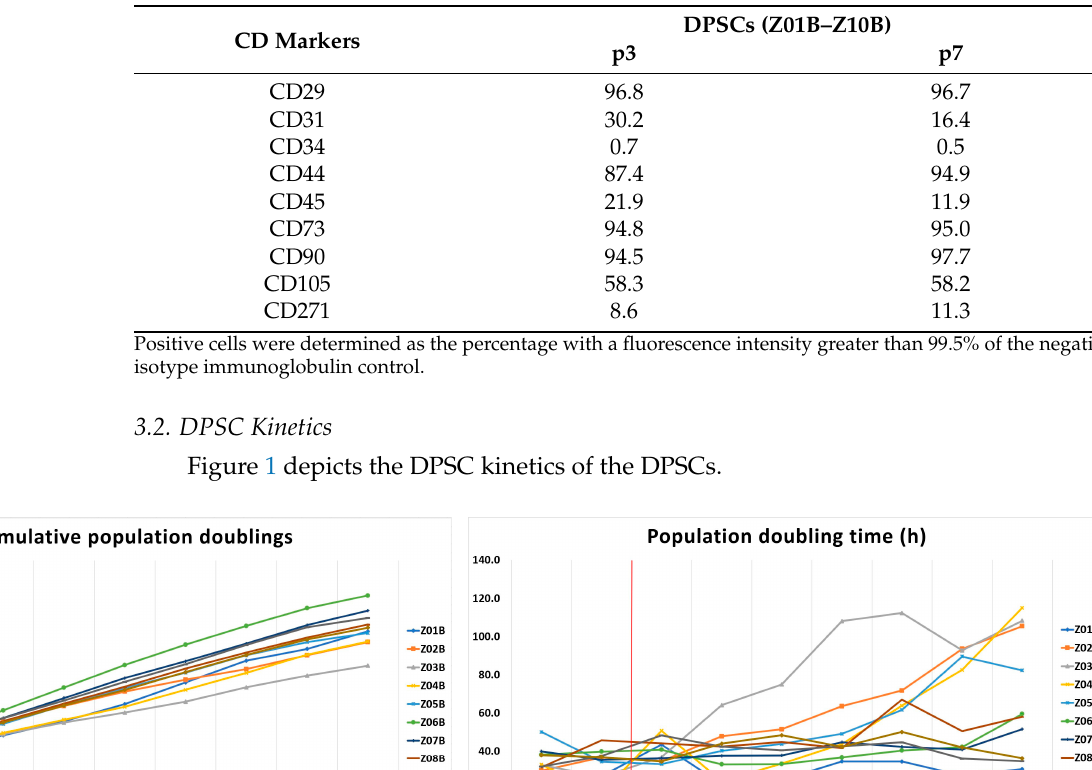
Table 1. The percentage of cells positively expressing tested cluster of differentiation (CD) markers. Data are shown as medians.